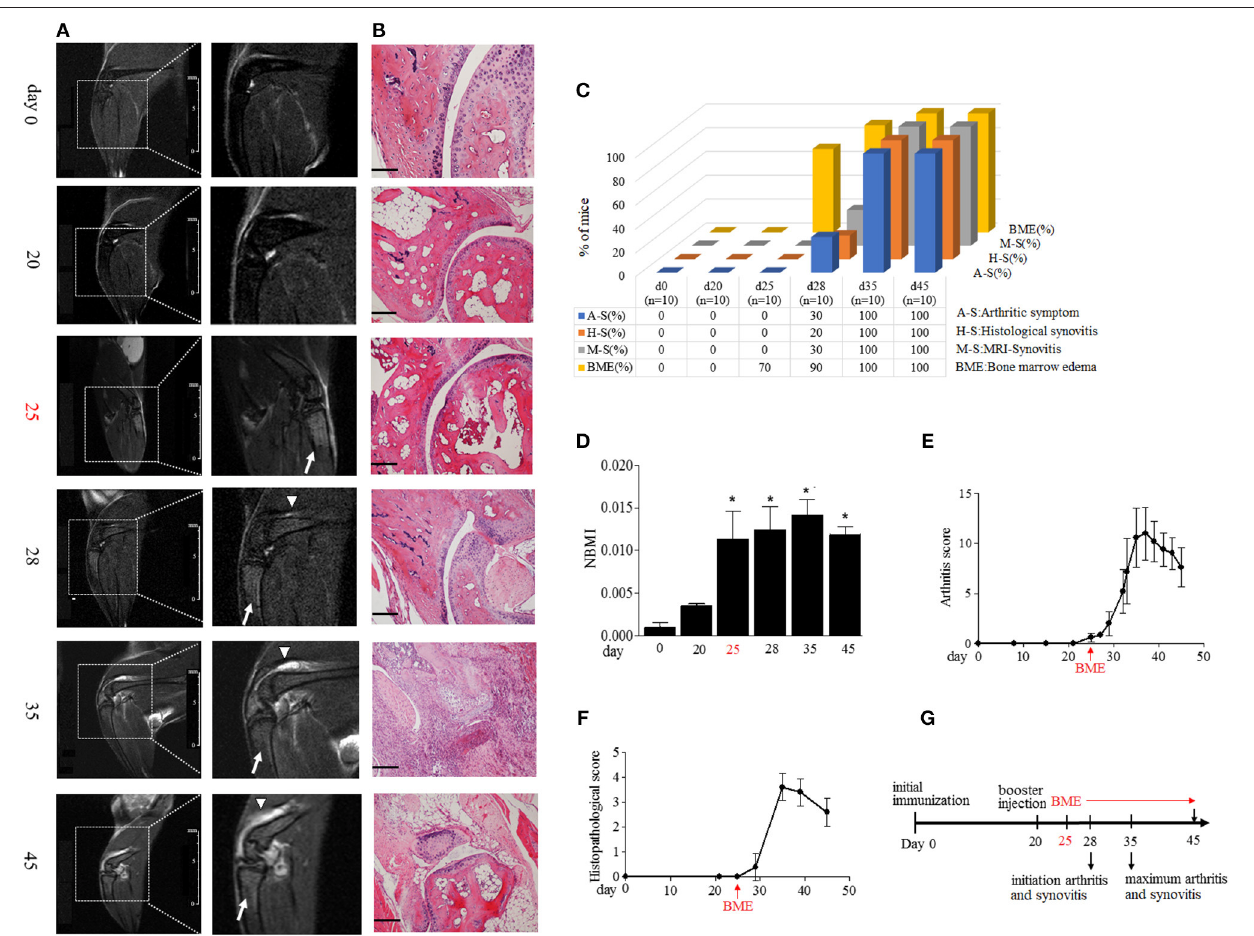
FIGURE 1 | BME precede the arthritic symptoms and synovitis during the development of CIA. (A) Representative MRI image of knee joints at different time points after first immunization in CIA mice. Insets are enlarged images of knee joints. Arrows indicate short time inversion recovery MRI BME signal. Triangles indicate synovitis. (B) Representative histological sections of CIA. Scale bar, 100 µ m. (C) Proportion of the occurrence of arthritic symptoms (A-S), histological synovitis (H-S), MRI detected synovitis (M-S), and BME in mice at the indicated time of CIA process ( n = 10, at each time point). (D) BME in panel A was quantified using normalized bone marrow intensity (NBMI). Values are means ± SD (* p < 0.05, compared with day 0). (E,F) Arthritis (E) and histopathological (D) scores of CIA mice. (G) Schematic diagram of experiments and the time point of appearance of arthritic symptoms, BME, and synovitis during the development of CIA. The first time of BME appearance during the CIA process was marked with